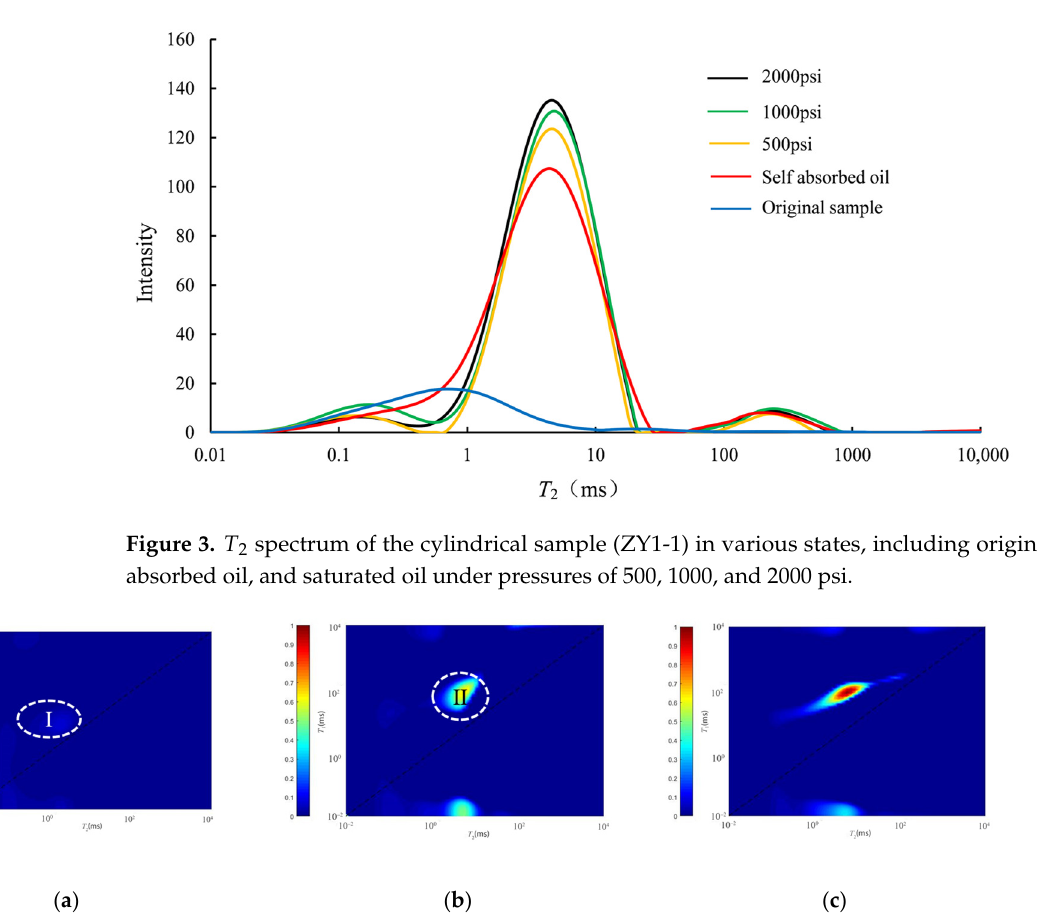
Figure 2. The particularly designed stepwise multi-temperature anaerobic heating equipment. ( a ) Schematic diagram of the equipment. 1—pyrolysis chamber, 2—exhaust valve, 3—the first pressure sensor, 4—the second pressure sensor, 5— condenser, 6—collecting tube, 7—suction filter pump, 8—supporting platform, 9—main power switch, 10—suction pres- sure indicator, 11—heating switch, 12—pressure indicator in the kettle, 13—power control box, 14—temperature control meter, 15—pumping switch. ( b ) The real developed equipment.